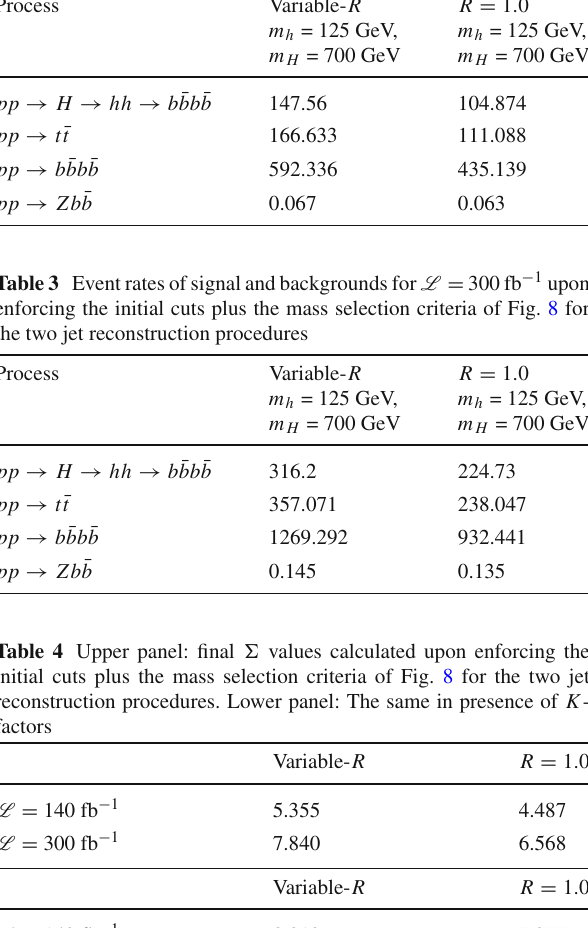
Table 5 Upper panel: final (cid:16) values calculated upon enforcing the initial cuts plus the mass selection criteria of Fig. 8 for the two jet reconstruction procedures using Trimming grooming techniques. Lower panel: the same in presence of K